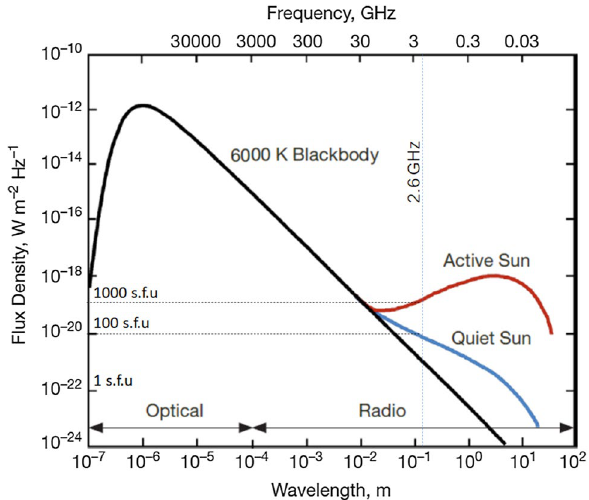
Figure 4. Solar radiation spectrum at optical and radio frequencies extracted from Christian Ho, Stephen Slobin, Anil Kantak, and Sami Asmar 17 . At wavelengths greater than 1 cm, the active sun (red line) and quiet sun (blue line) deeply differ in terms of radiance, not following blackbody emittance at 6000 K (black line). The specific situation at 2.6 GHz is added with the dotted lines, showing one order of magnitude s.f.u. variation (approximately in the range 100–1000 s.f.u).